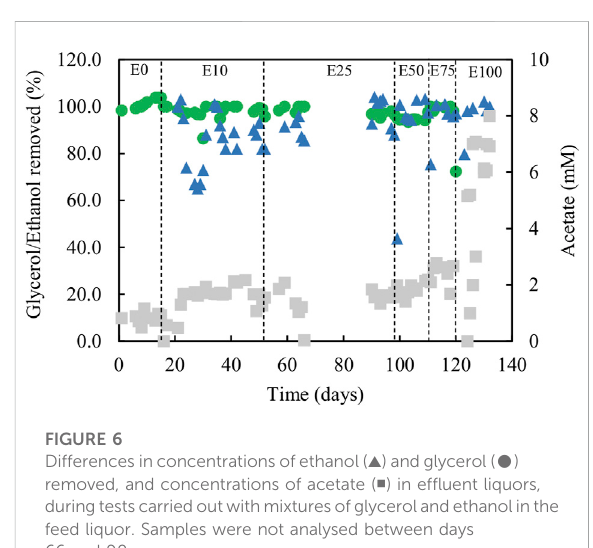
FIGURE 6 Differences inconcentrations ofethanol ( ▲ )and glycerol ( C ) removed, and concentrations of acetate ( ■ ) in ef fl uent liquors, duringtestscarriedoutwithmixturesofglycerolandethanolinthe feed liquor. Samples were not analysed between days 66 and 90.